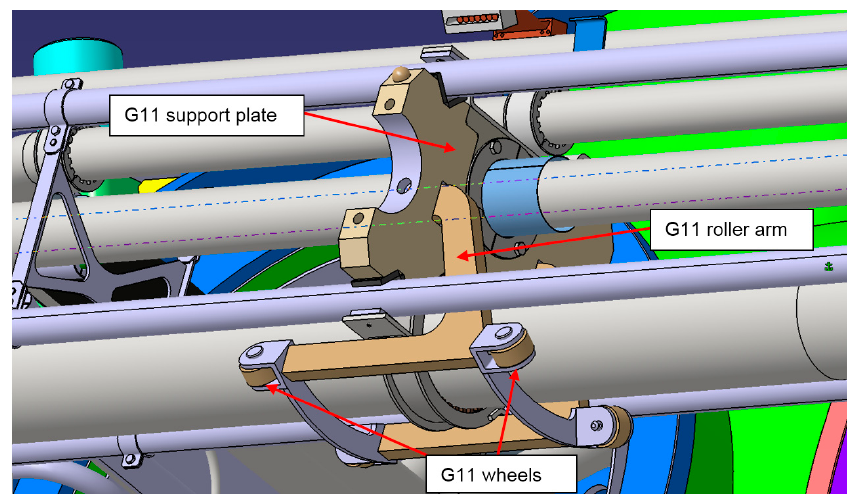
Figure 12. PP The sliding support of process pipes, G11 roller arm, and G11 wheels.